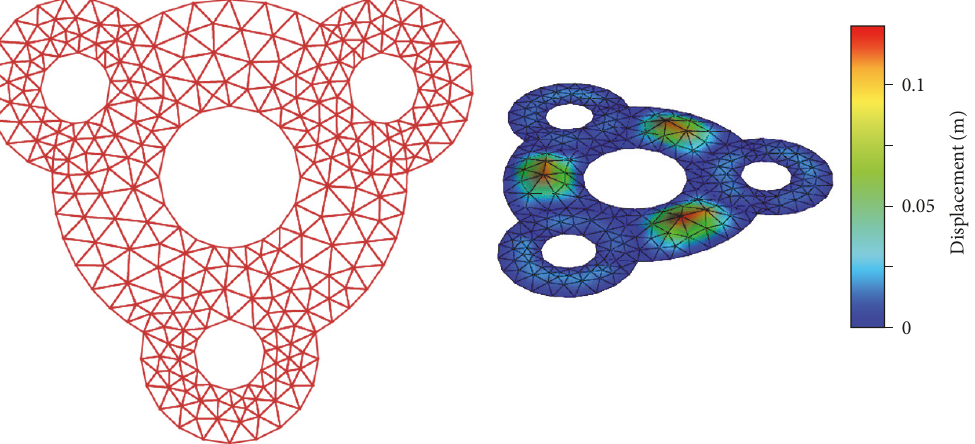
Figure 8: The clamped polyurethane gasket under the uniform load: the initial mesh and the isometric view of the resulting vertical deflection of the